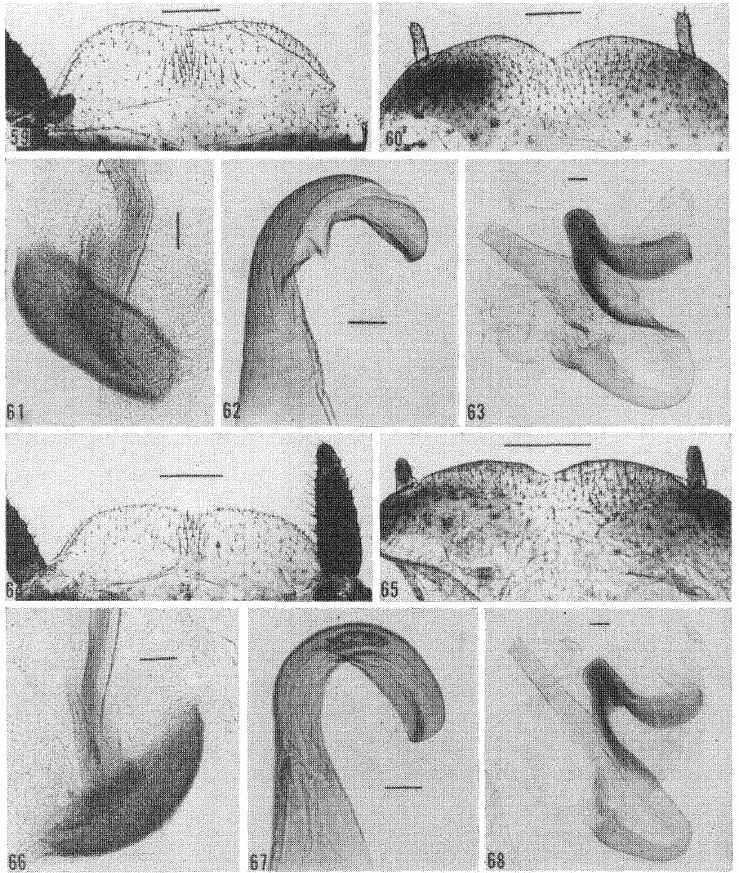
Figures 59-68. Calolampra aspera. Male supra-anal and subgenital plates, and genitalia. 59-63. (10 SAM), Clayton Crossing, S. A. (R2 in figure 62 damaged). 64-68. (12 SAM), Muloorina Stn., S. A. Scale: Figs. 59-60, 64-65 0.5 mm; Figs. 61-63, 66-68 0.1